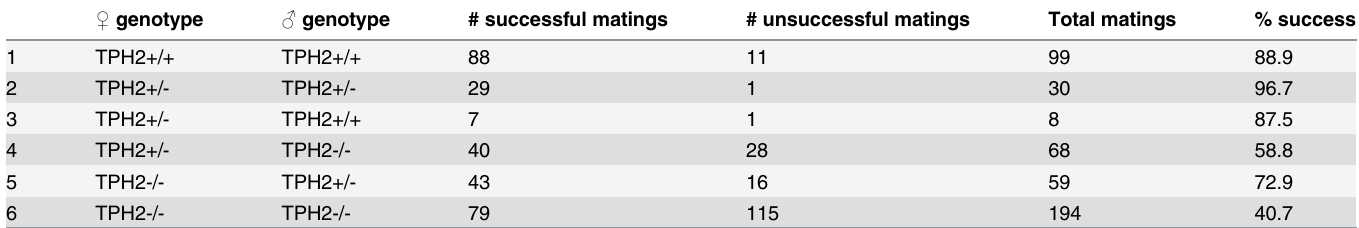
Mating pairs of the indicated genotypes were caged together for 21 days after which the male was removed. From this time forward, the female was housed alone until pups were born or until the passage of an additional 21 days. Matings were scored as successful if pups were born and matings that extended beyond the 21 day post-mating period without births were deemed unsuccessful. Statistical comparisons among rows and the level of signi fi cance is indicated below: row 1 different from rows 4 (p < 0.0001), 5 (p = 0.015) and 6 (p < 0.0001); row 2 different from rows 4 (p < 0.0001), 5 (p = 0.008) and 6 (p < 0.0001); row 3 different from row 6 (p = 0.011); row 4 different from rows 1 (p < 0.0001), 2 (p < 0.0001), and 6 (p = 0.011); row 5, different from 1 (p = 0.015), 2 (p = 0.008), and 6 (p < 0.0001); and row 6, different from rows 1 (p < 0.0001), 2 (p < 0.0001), 3 (p = 0.011), 4 (p = 0.011), and 5 (p <